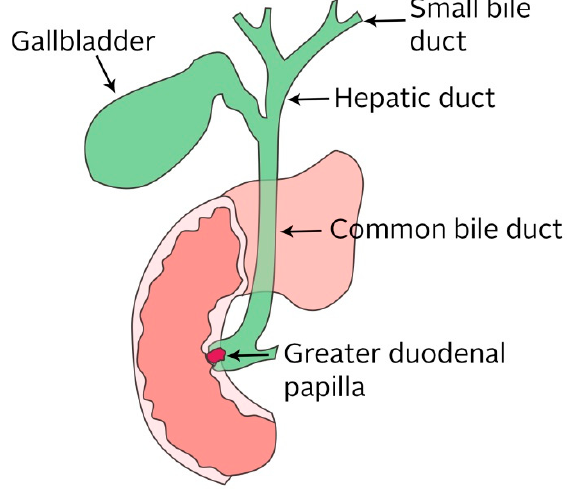
Figure 4. Diagram of biliary tracts.